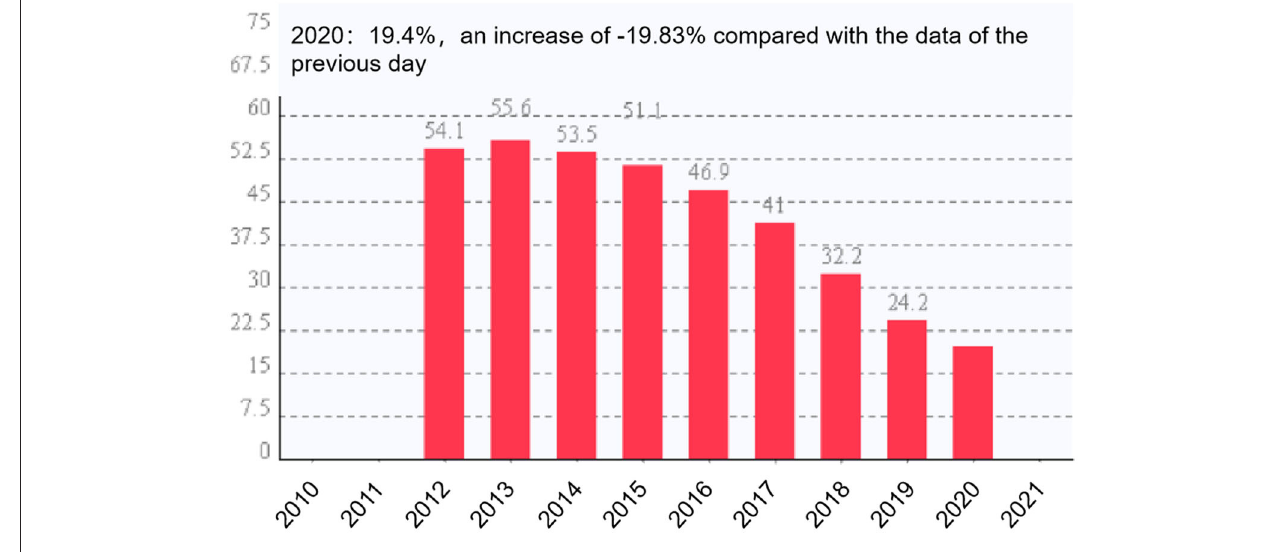
FIGURE 1 | Statistics of children in distress in China in